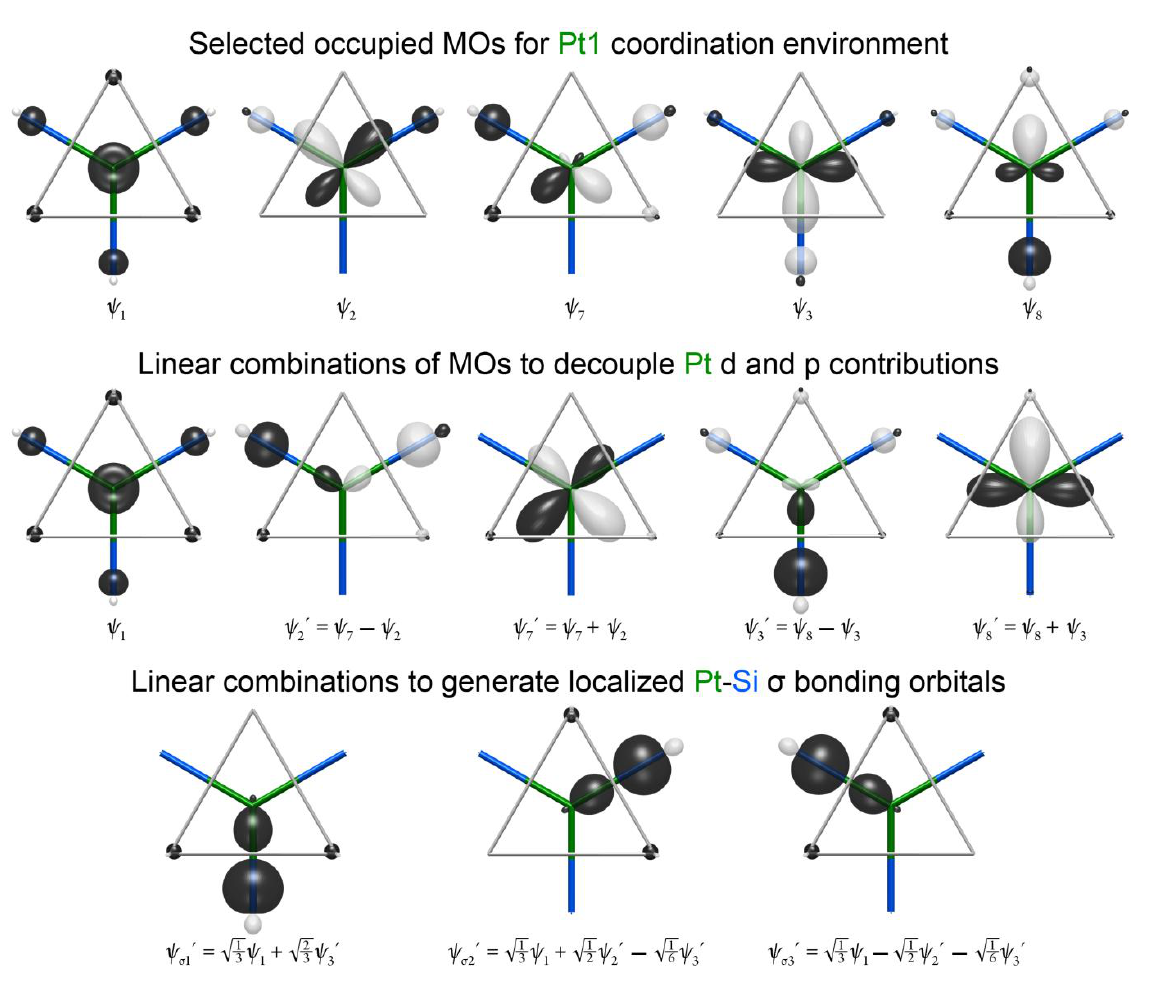
Figure 5. The generation of localized Pt1–Si bonding orbitals from linear combinations of the occupied MOs in Figure